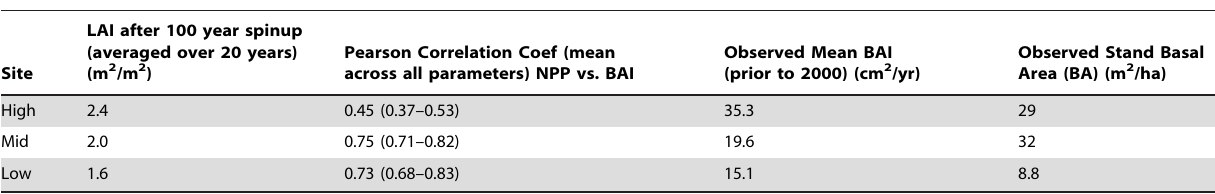
Table 2. Modeled and observed stand characteristics prior to the drought.